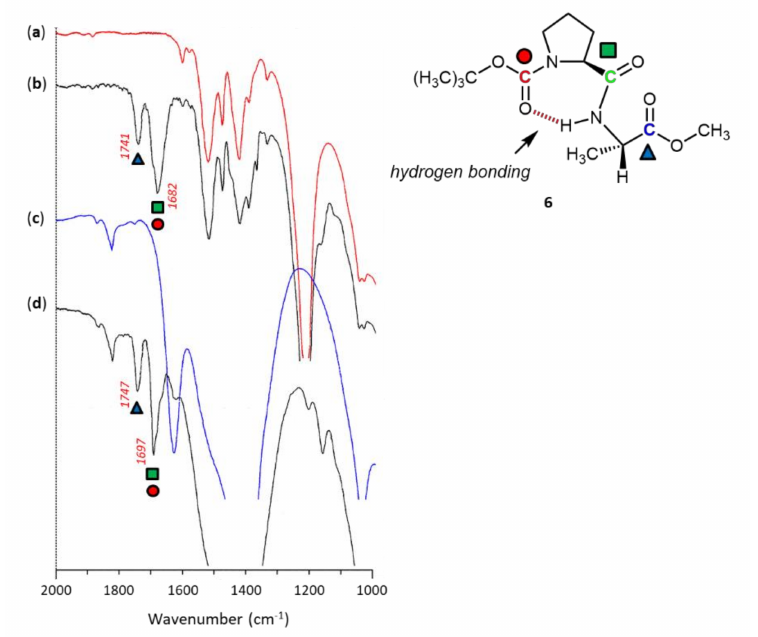
Figure 14. IR spectra of N -Boc-L-proline-L-alanine-OMe 6 : ( a ) CHCl 3 (red line); ( b ) 20 mmol/L of 6 in CHCl 3 ; ( c ) acetonitrile (blue line); ( d ) 20 mmol/L of 6 in